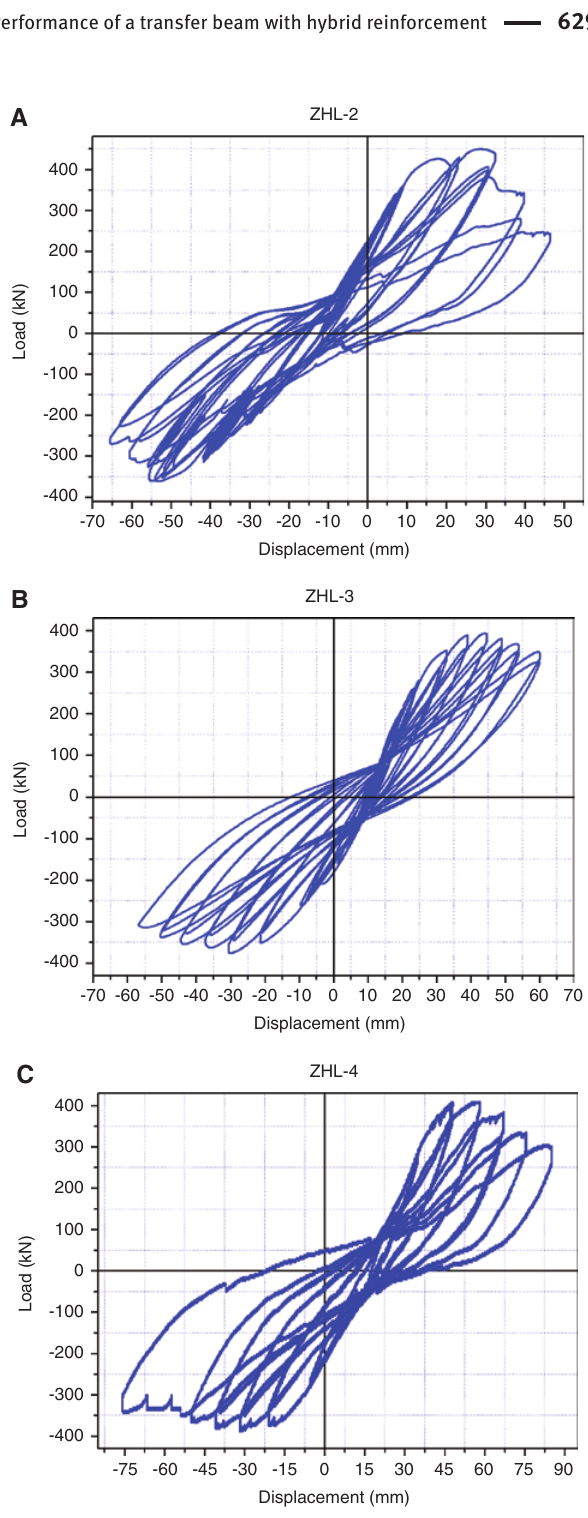
Figure 7: Hysteresis curves of three specimens (ZHL-2, ZHL-3, and ZHL-4): (A) ZHL-2 hysteresis curve; (B) ZHL-3 hysteresis curve; (C) ZHL-4 hysteresis